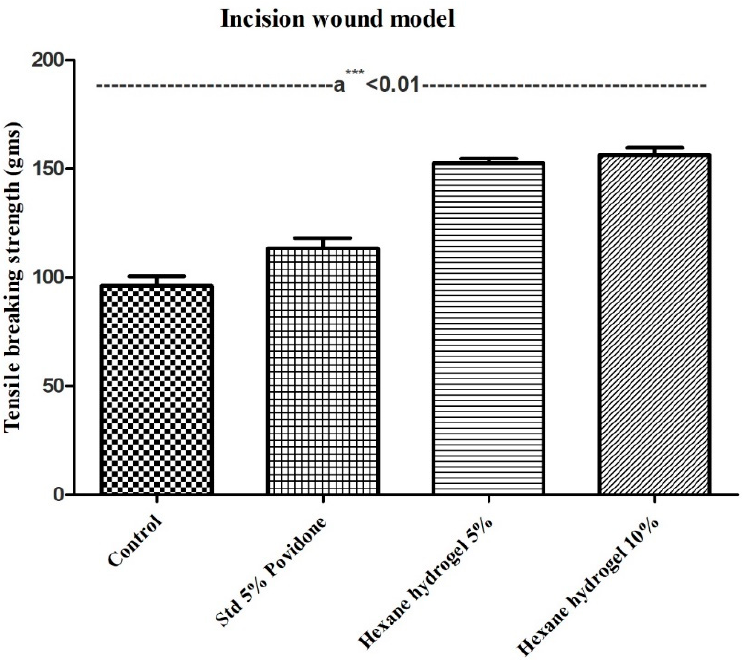
Figure 4. Effect of topical application of ointment of Moringa oleifera n- hexane seeds extracts tensile breaking strength of incision wound. Mean ± SD, analyzed by one- way ANOVA followed by Bonferroni’s multiple comparison test post hoc analysis; a*** < 0.01 vs. control, standard, and test drugs 8th day.